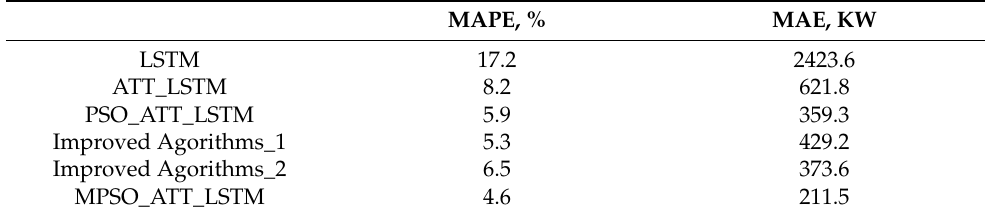
Table 6. Model evaluation.